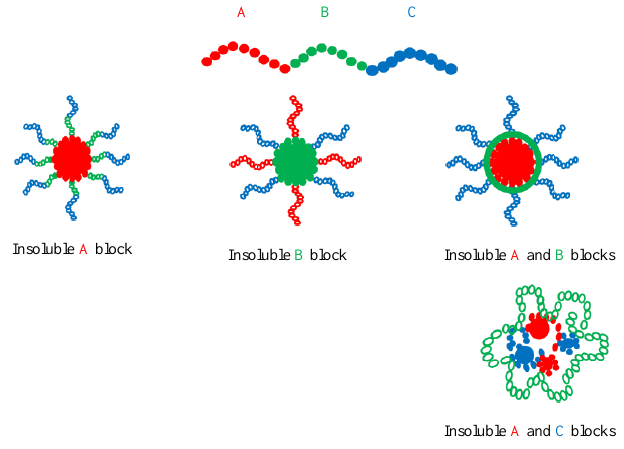
Figure 5. Basic micellar morphologies for linear ABC triblock terpolymers.